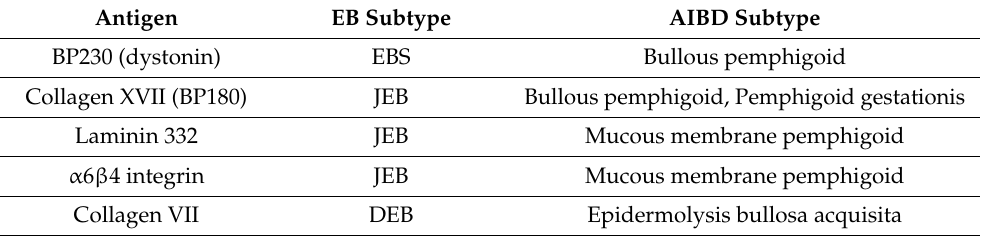
Table 1. Select autoantigens shared between pemphigoid diseases and epidermolysis bullosa.